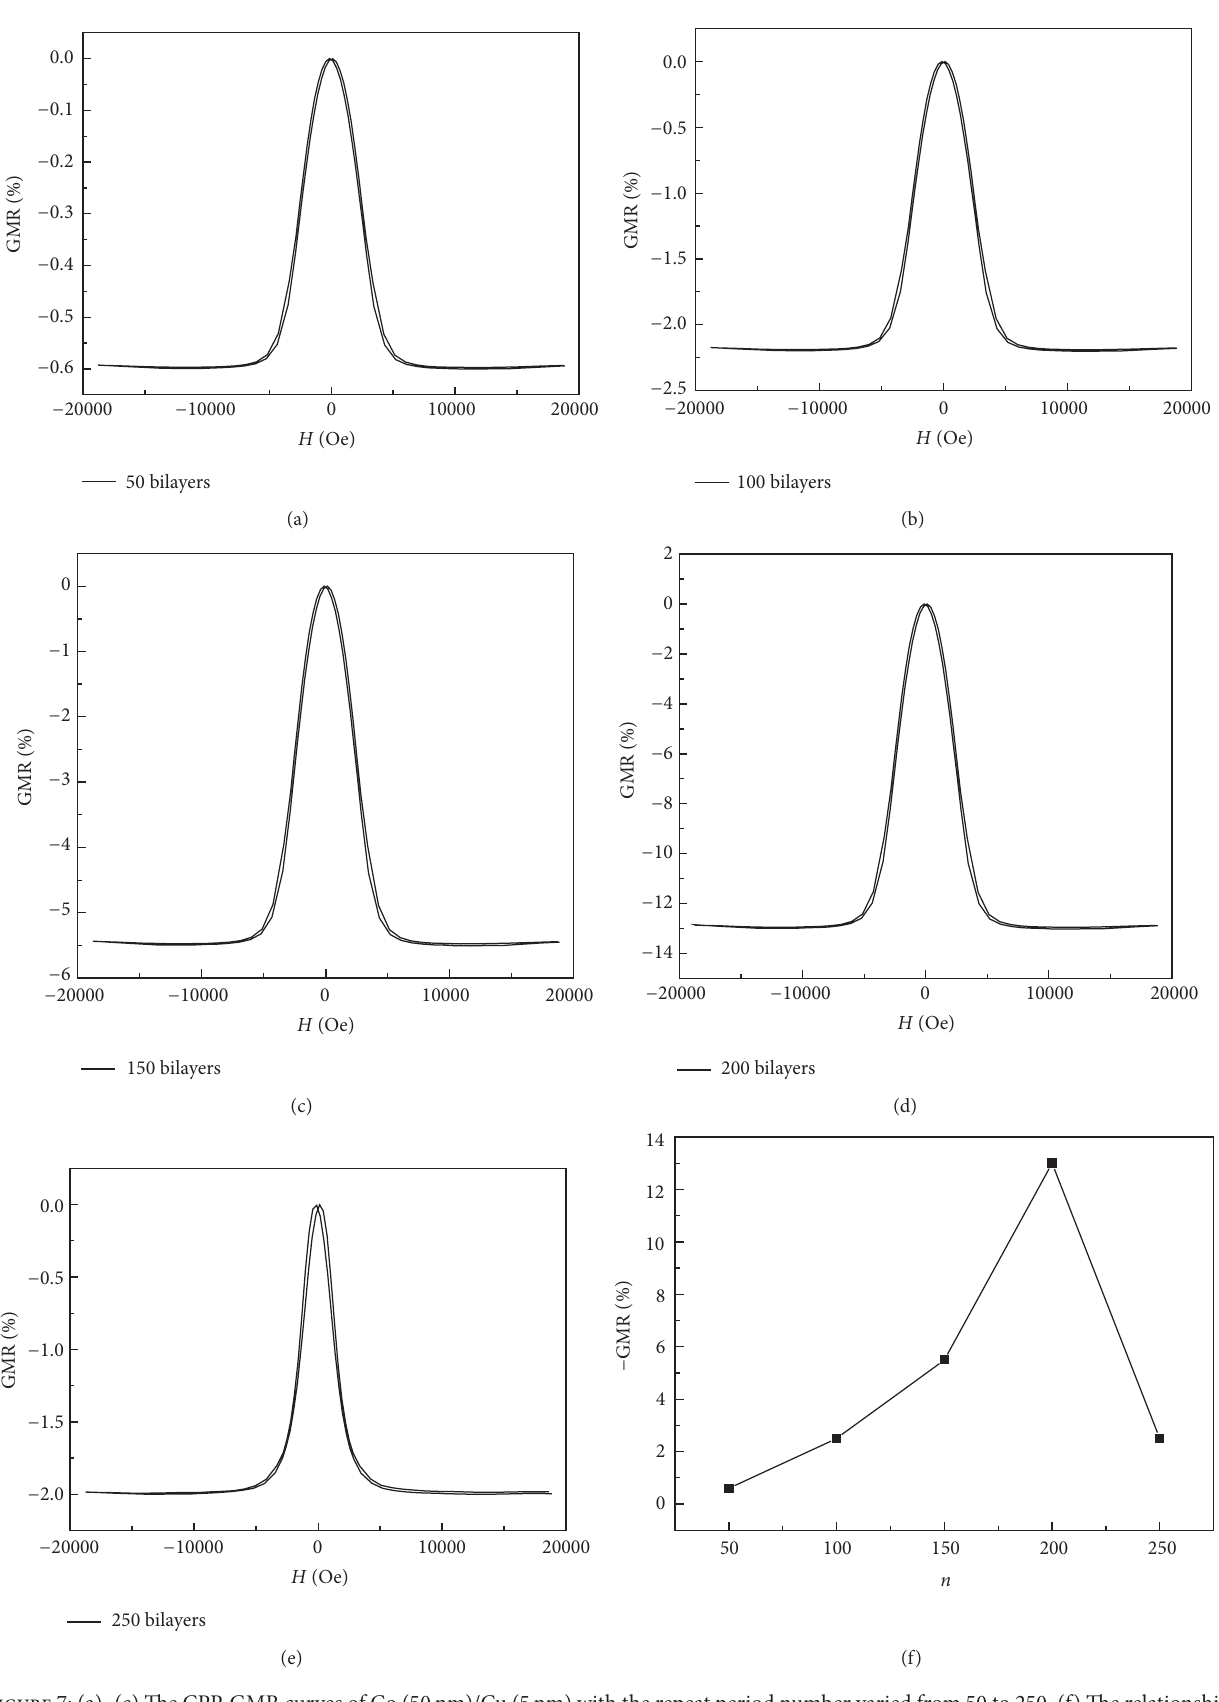
Figure 7: (a)–(e) The CPP-GMR curves of Co (50 nm)/Cu (5nm) with the repeat period number varied from 50 to 250. (f) The relationship between the CPP-GMR ratio and the number of bilayers of the Co/Cu multilayered nanowires electrodeposited into PAA